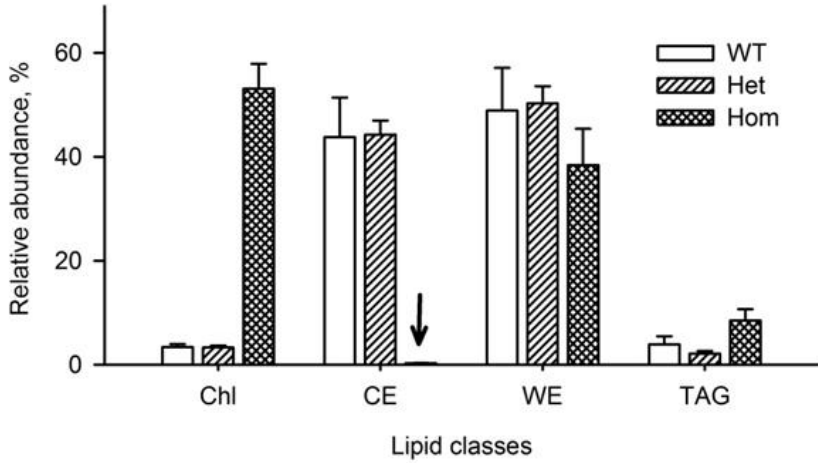
Figure 7. Effects of Soat1 ablation on the balance of major Meibomian lipid classes. An almost complete suppression of the biosynthesis of cholesteryl esters was observed in Soat1 −/− mice (black arrow). Normalized results are shown as mean ± standard deviation values. Sum of Chl, CE, WE, and TAG for each genotype equals 100%.